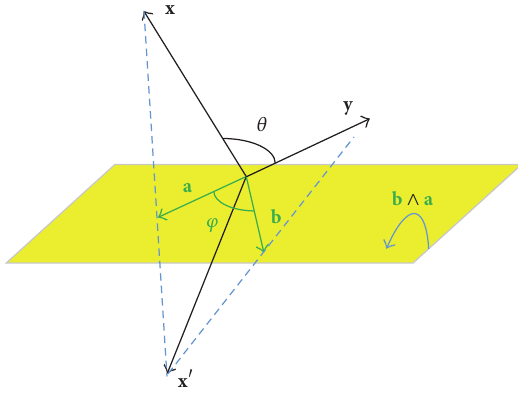
Figure 3: Rotation of vector x .